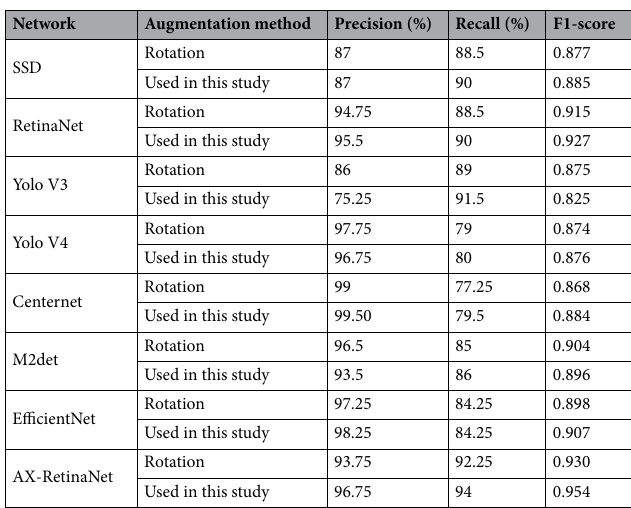
Table 2. Precision, Recall, and F1-score values of the detection and identification results of different networks using different augmentation methods.